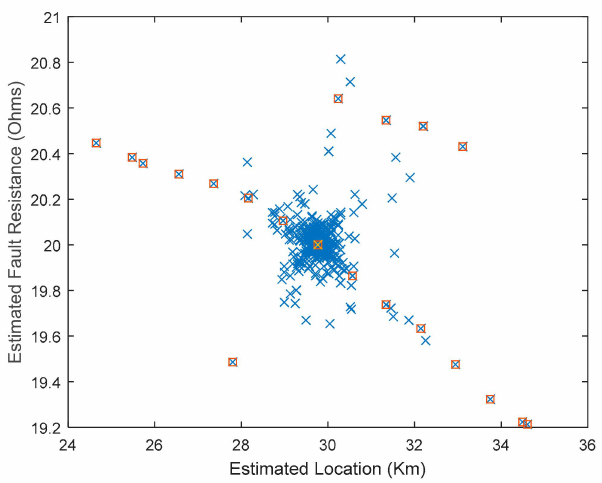
Figure 13. Fault location and resistance: